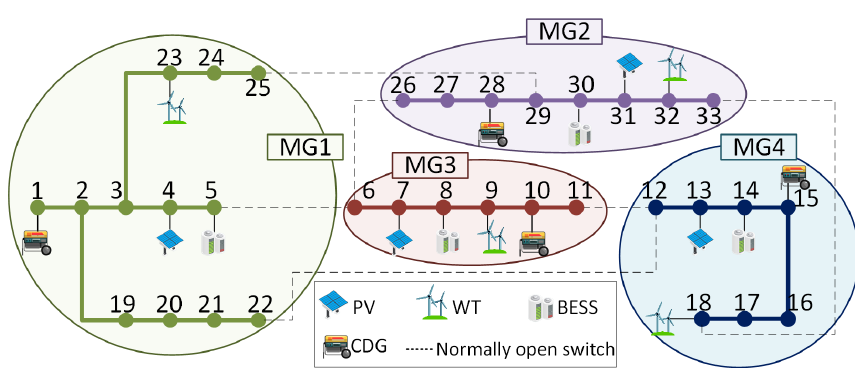
Figure 4. Modified IEEE 33-bus distribution system with four MGs.